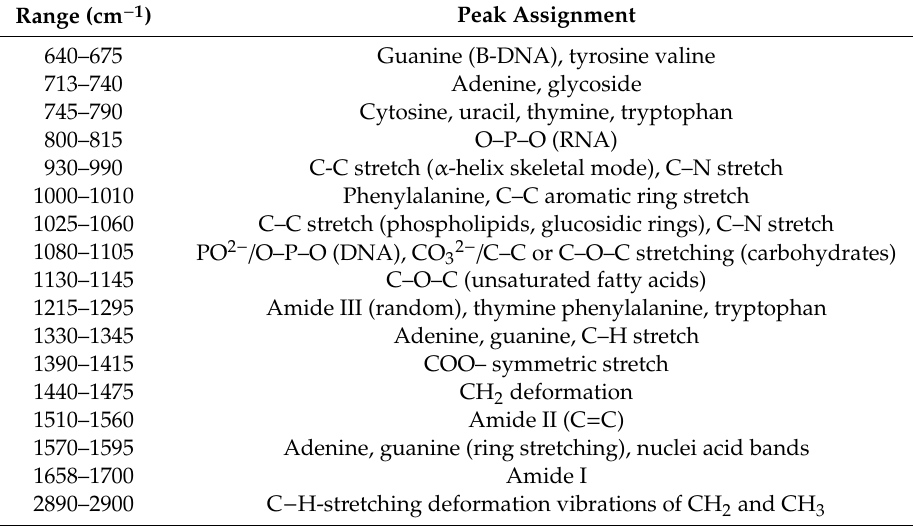
Table 2. Raman spectra and band assignments observed in common pathogens such as S. pneumoniae , H. influenzae , P. aeruginosa , Moraxella , Streptococcus pyogenes , and Staphylococcus aureus [58–61,64].